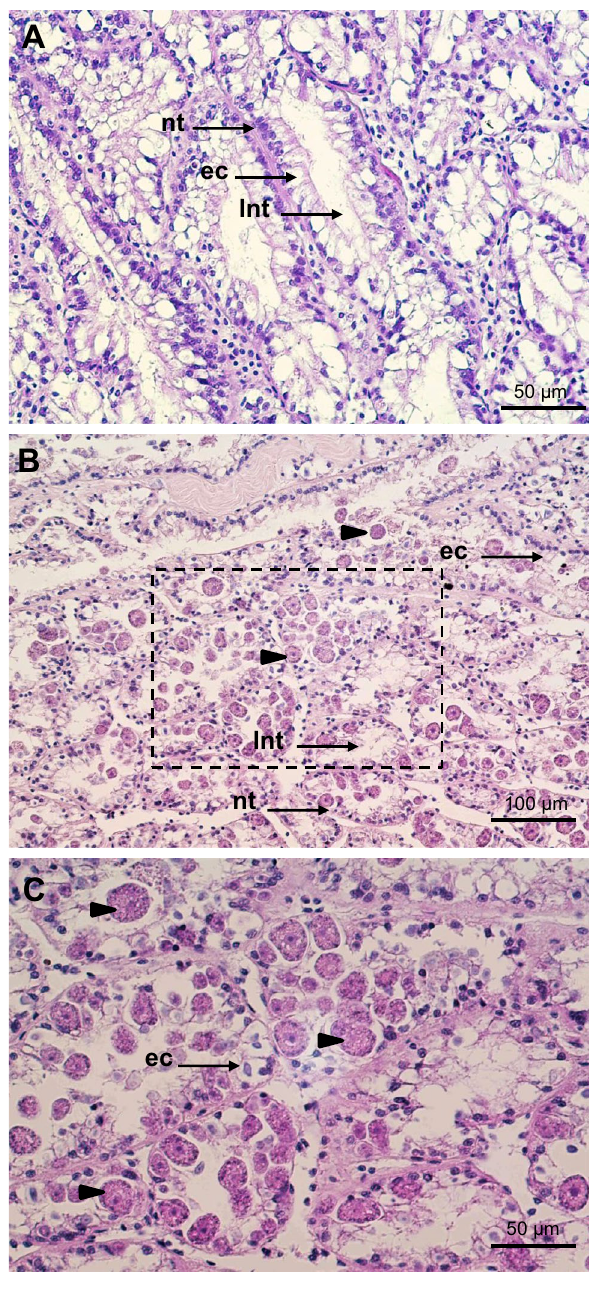
Figure 3. Micrographs of histological sections presenting healthy ( A ) and infected ( B and C ) scallop kidneys (H&E stain). ( C ) represents a high magnification capture of the area pointed in B and underlines the extensive disruption of kidney tubules caused by heavy BSM (Bay Scallop Marosporida, black arrowheads) infection. ec: epithelial cell, lnt: lumen of nephridial tubule, nt: nephridial